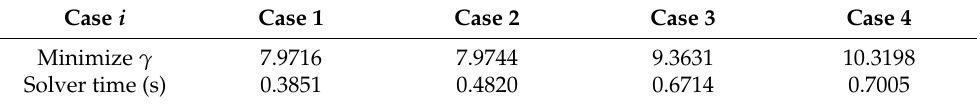
Figure 5. Evolution of filtering error (cid:107) e ( k ) (cid:107) for four cases. Table 1. The H ∞ performance index γ and solver time for different quantization density ρ i in case 2.